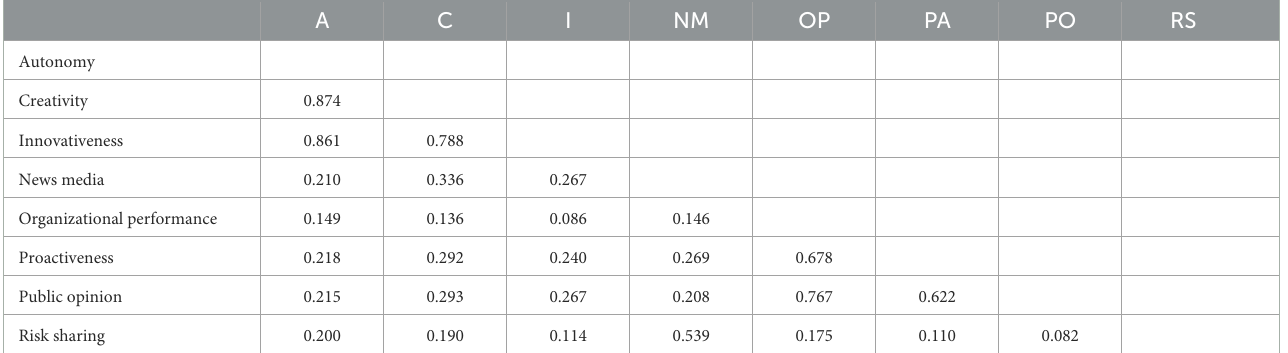
TABLE 4 Discriminant validity